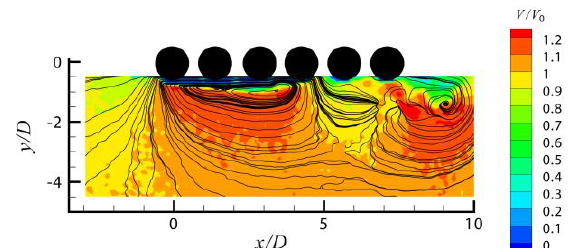
Fig. 8. Normalized velocity magnitude contour plot at second time step obtained for lateral region